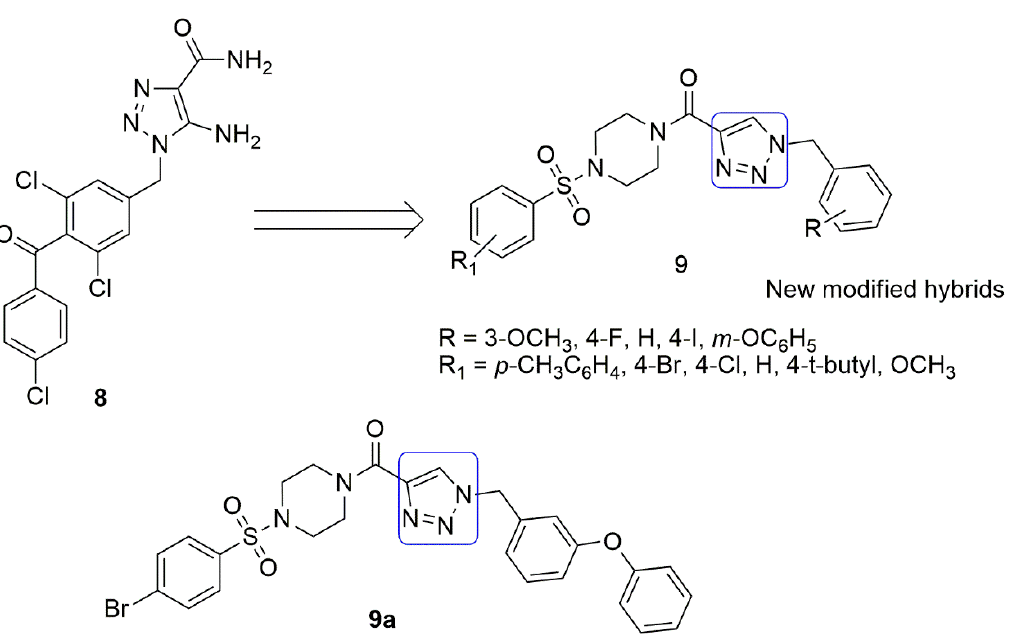
Figure 5. Chemical structures of 1,2,3-triazole, sulfonamide, and piperazine moieties that inhibit tubulin polymerization. tubulin